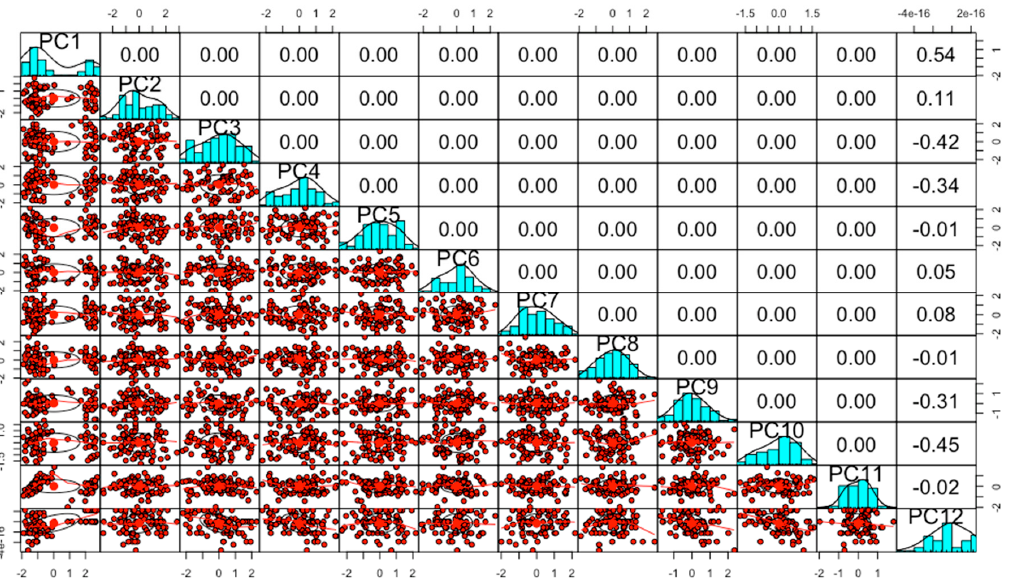
Figure 6. The Principal Components from balanced features set.